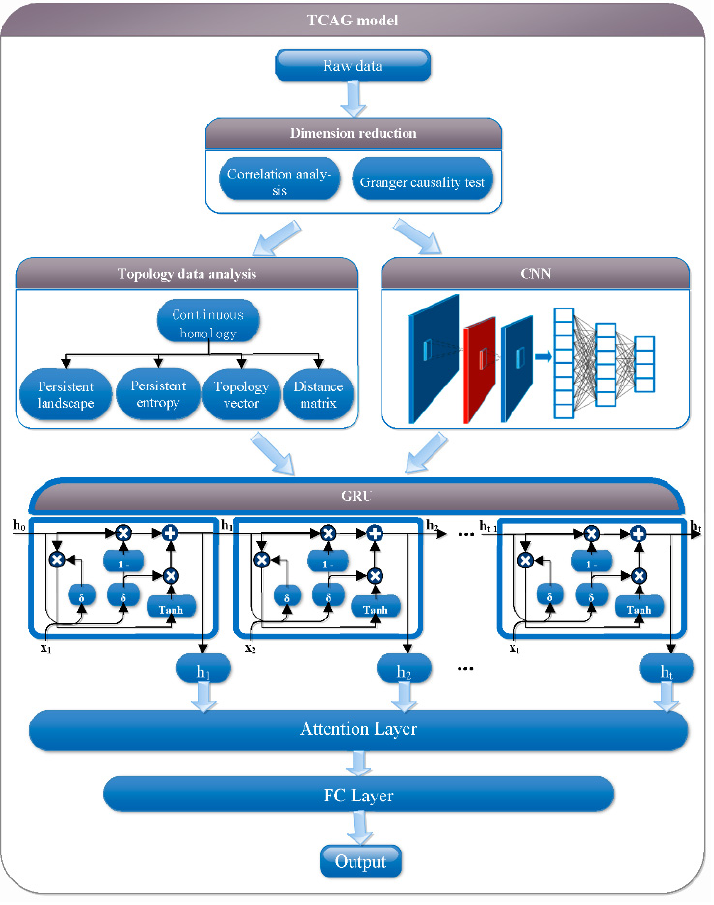
Figure 2. TCAG model